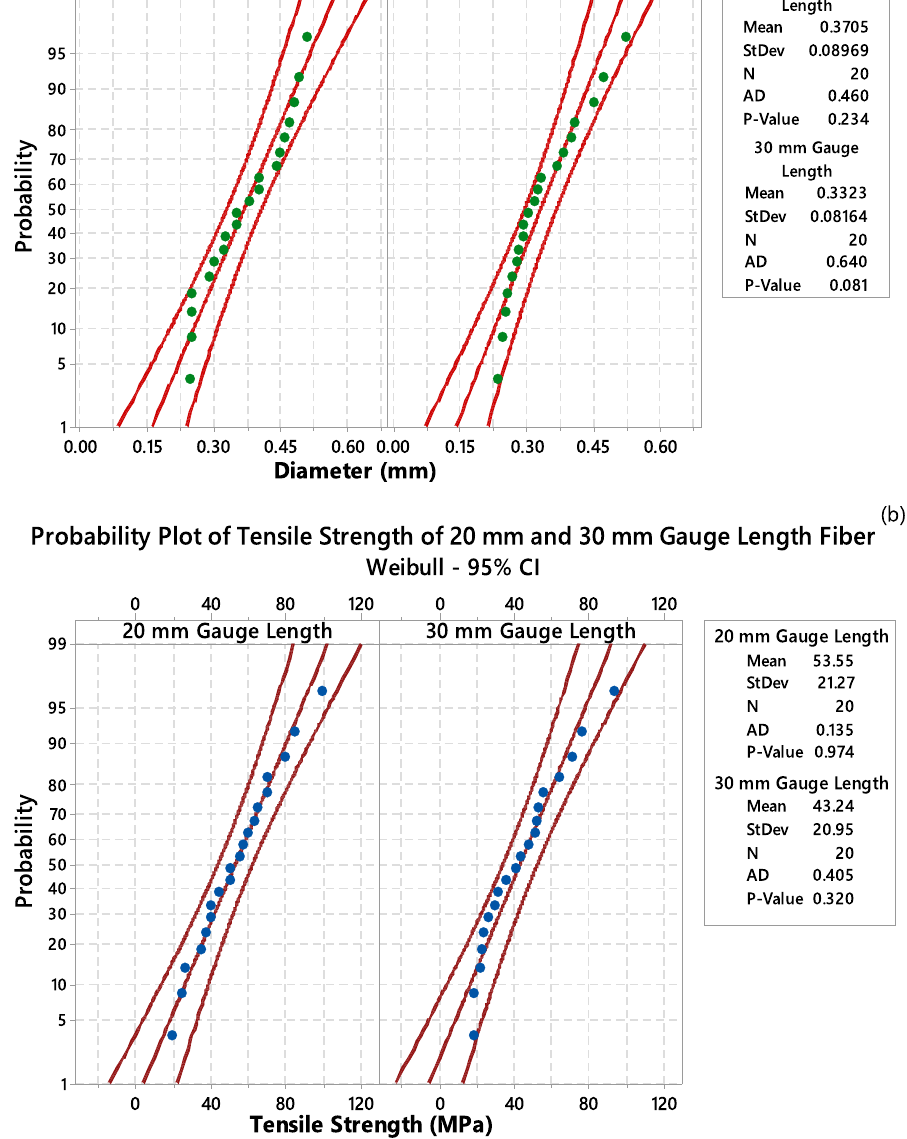
Figure 8. Weibull distribution plot ( a ) diameter and ( b ) tensile strength of CTF